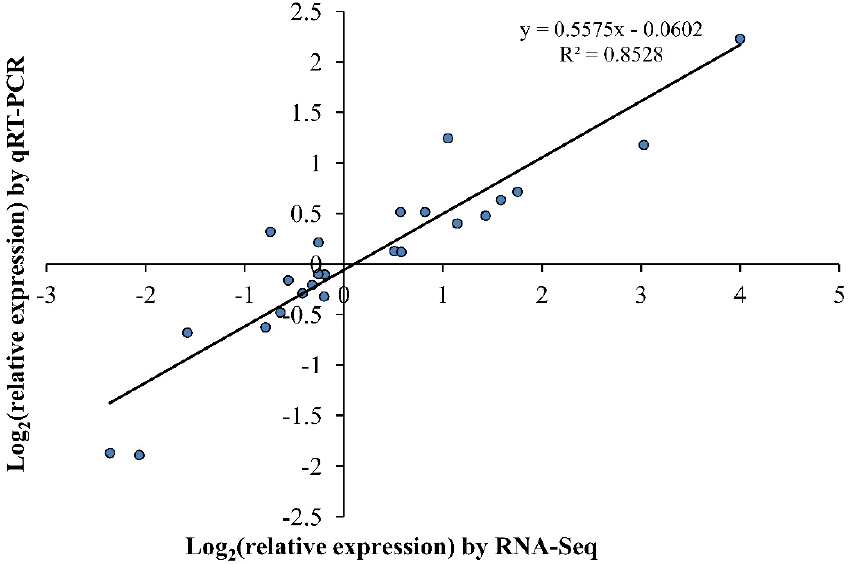
Figure 8. Correlation analysis of the eight DEG HP for BI04, BI28, and DH45 under CK vs. LN conditions by qRT-PCR and RNA-Seq. The Pearson correlation coefficient (R 2 ) was 0.8528.